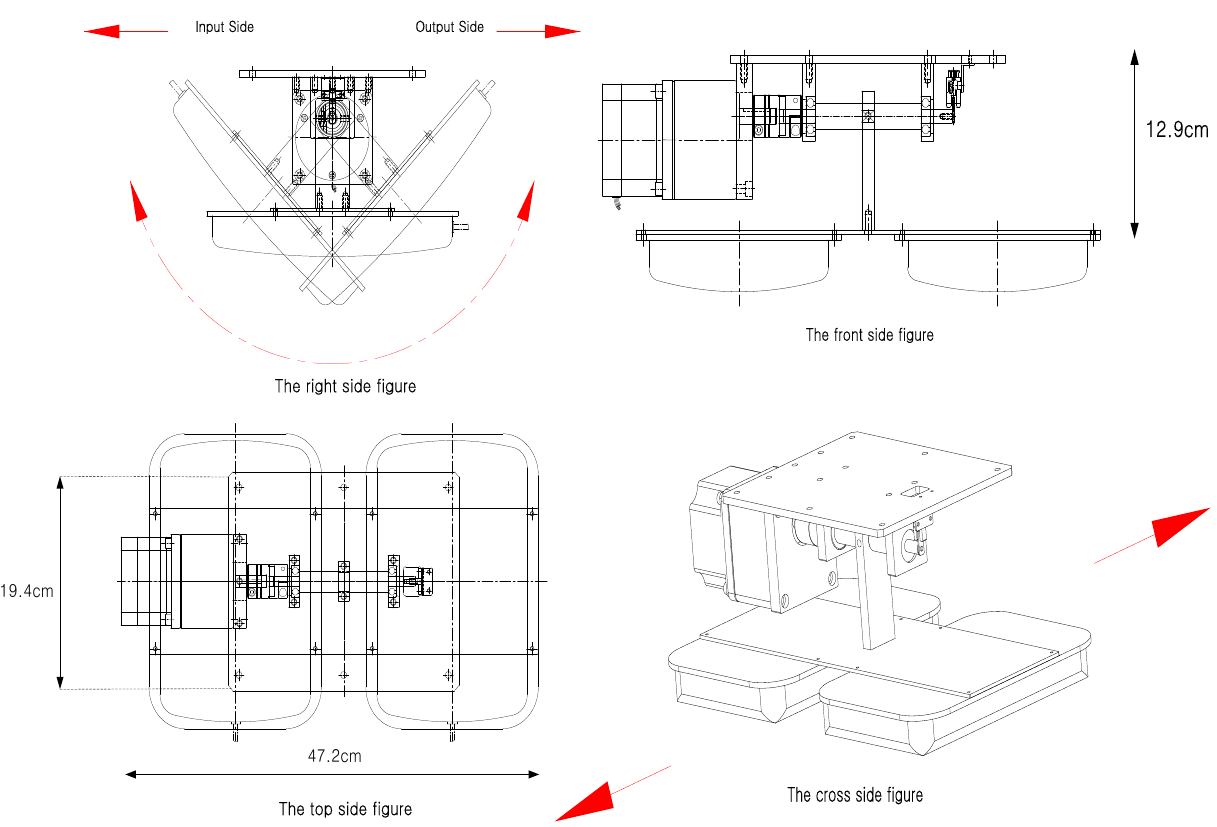
Figure 5. A drawing of the antenna control